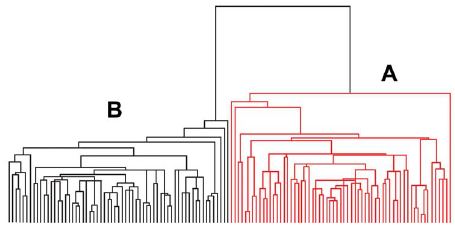
Figure 6. Clustering for individuals of the 126 samples. (A) The 63 disease samples. (B) The 63 control samples.